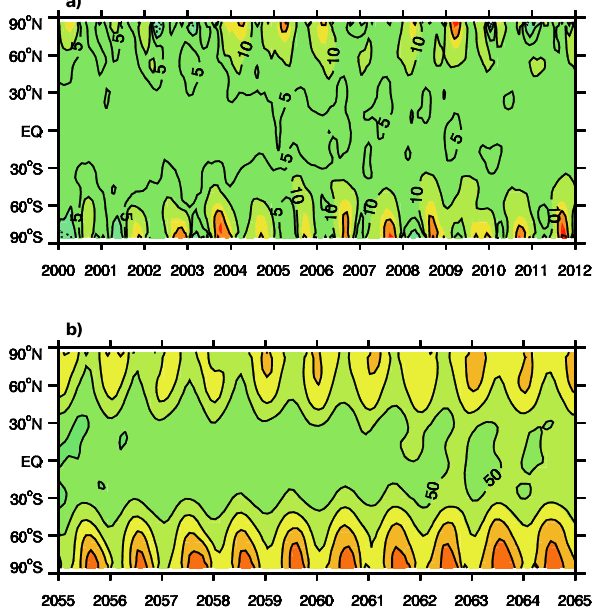
Fig. 5. Simulated year-to-year evolution of the total ozone destruc- tion prevented by the MPA. The values for isolines in percent are for (a) 2000–2012: 5, 10, 30; for (b) 2055–2065: 50, 60, 70, 80.